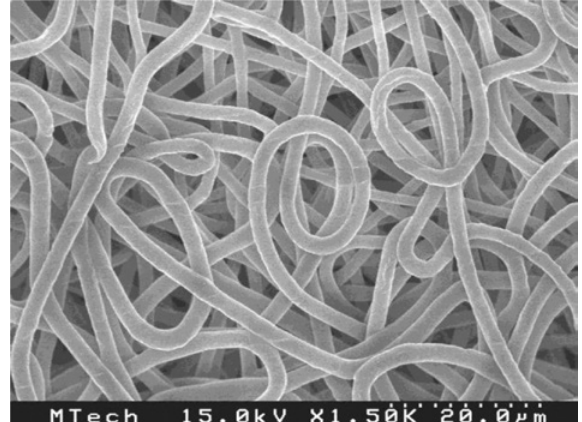
Figure 5: SEM micrograph of nanofibers produced via solution electrospinning. Fiber diameter ranged from 800 nm to 1 μ m. Polymer used during electrospinning was 8 wt% polycaprolactone in